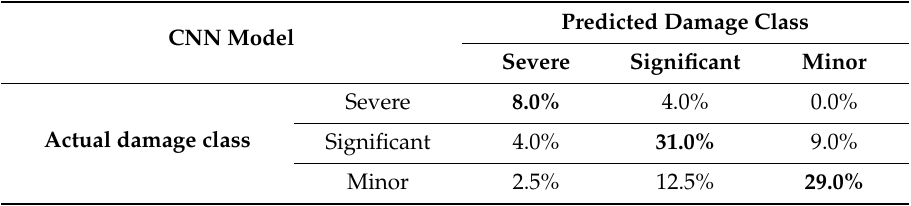
Table 5. Example of confusion matrix for the CNN